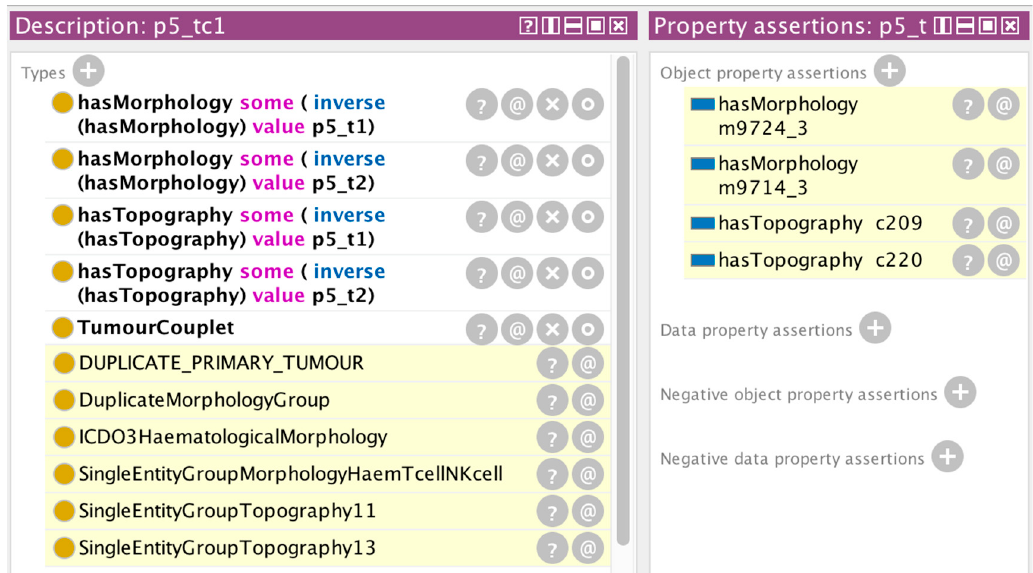
Figure 10. Results of the reasoning operation for the tumour couplet p5_tc1. Only the morphology codes are equivalent, but since they are haematological-type morphologies the tumour couplet is an invalid MPT independent of the topography codes.